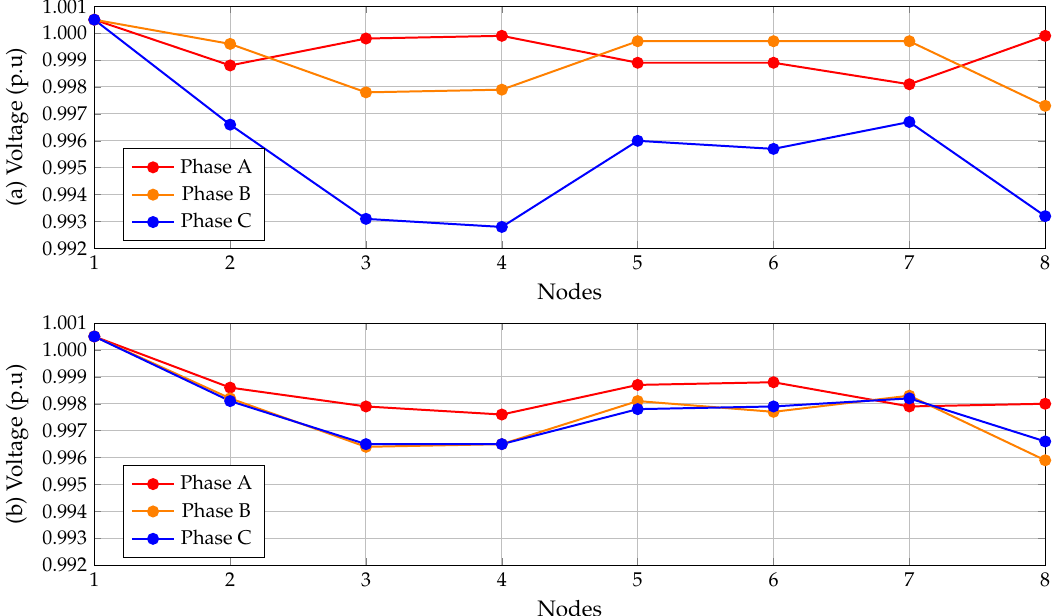
Figure 13. Voltage profiles in the 8-node test system: ( a ) modified benchmark case and ( b ) proposed